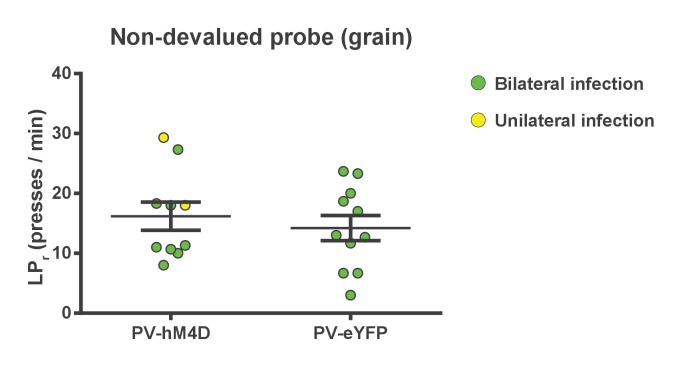
Chemogenetic inhibition of FSIs in dorsolateral striatum does not affect operant lever pressing in general.Lever press rates during the non-devalued probe test. Mice from both groups were pre-fed a sensory-specific satiety control pellet (grain-only) and administered CNO (5 mg/kg, intraperitoneally) prior to undergoing a 3 min extinction probe test to assess the effect of inhibiting FSIs on operant behavior independent of sensitivity to outcome value, i.e. habit. Mice expressing hM4D and eYFP in FSIs of the DLS did not differ in response rates (p=0.53, n = 10 and 11 mice), indicating that inhibition of DLS FSIs did not affect general lever pressing behavior. Two mice displayed unilateral infection (yellow) as opposed to bilateral (green). Because inclusion or exclusion of these data did not affect statistical results for any behavioral measure, data were included and indicated as above. Data are represented as mean ±SEM.